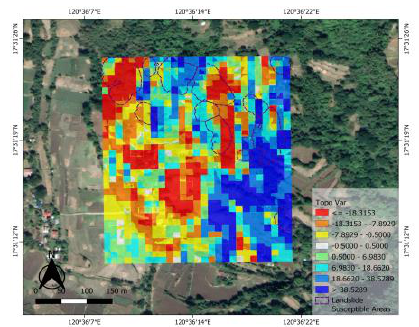
Figure 14 . Terrain variations between DTMs from LiDAR and Sentinel-1.